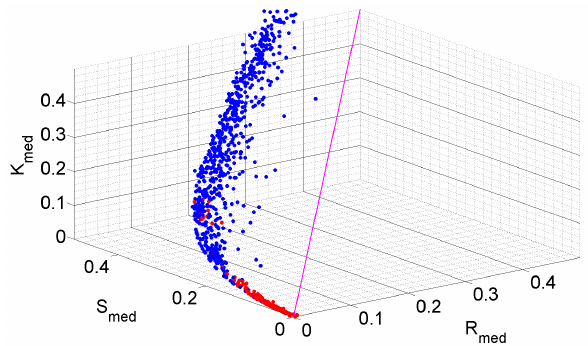
Figure 2: Correlation between roundness-based features. The feature values were normalized to [0; 1] . Blue points come from non-degenerate and red points from degenerate pairs. The ma- genta line is used to show the location of the linear relationship.